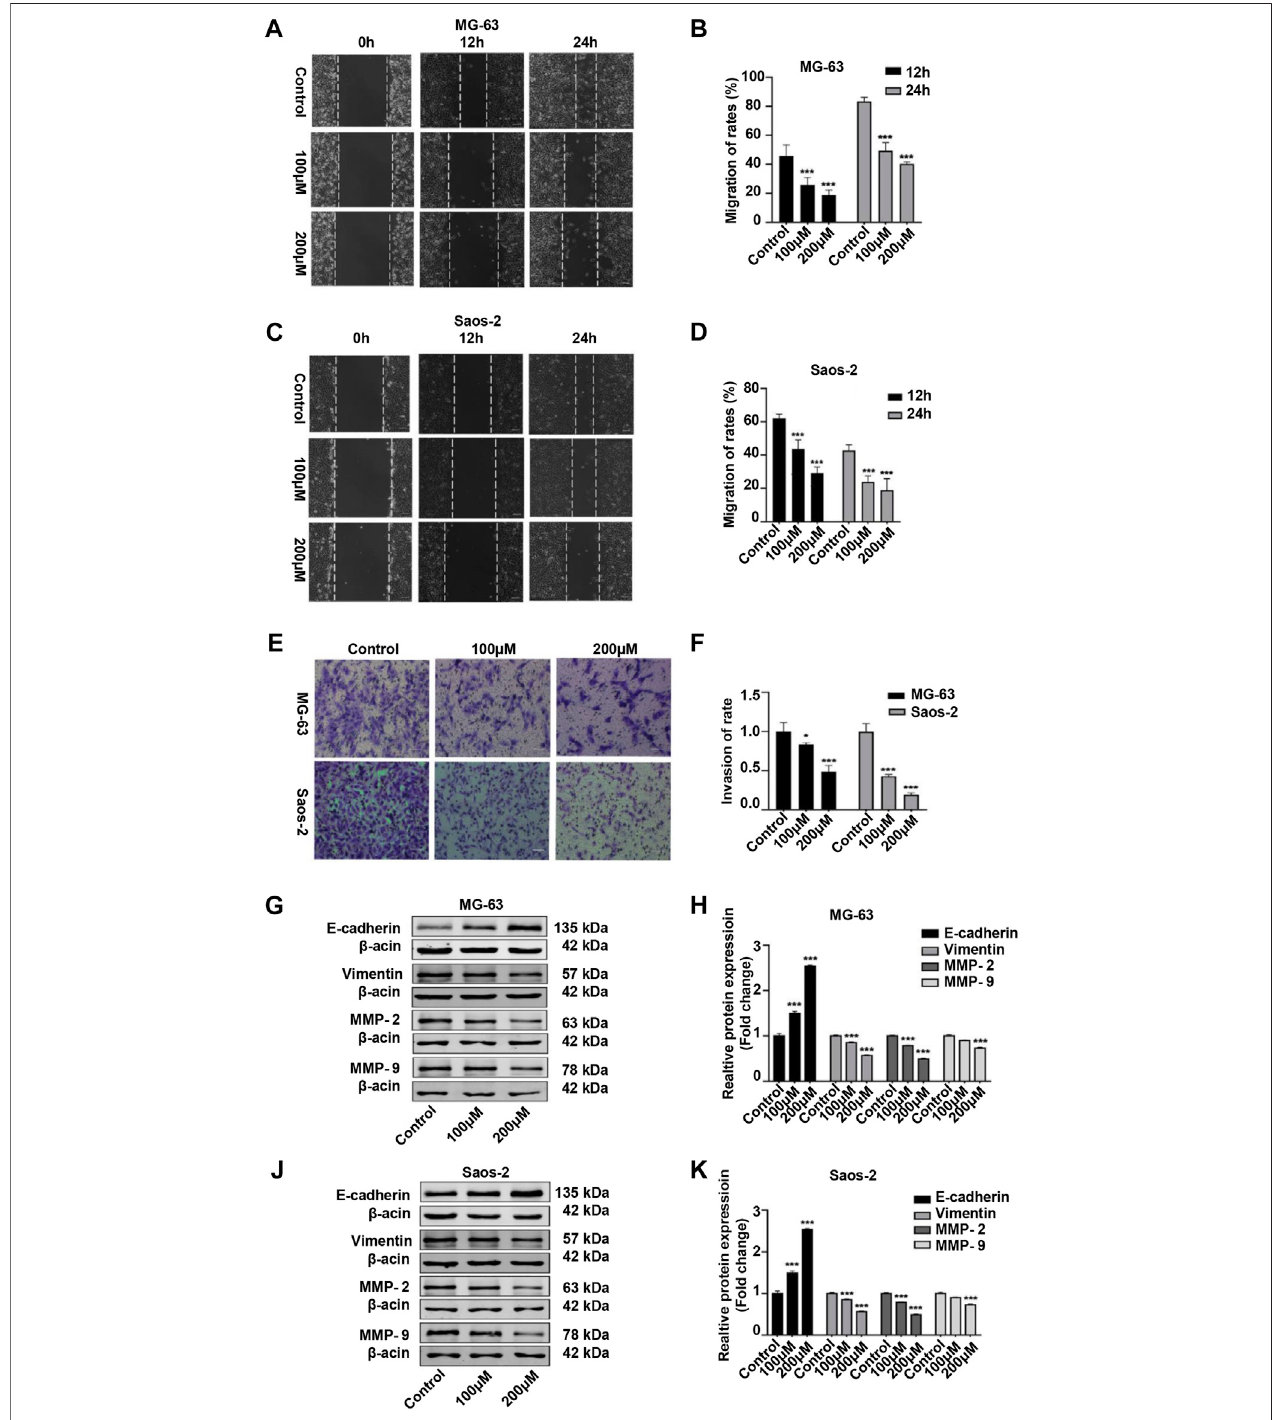
FIGURE 7 | Peiminine suppressed migration and invasion of osteosarcoma (OS) cells. (A,C) Wound healing assay in OS cells treated with peiminine for 0, 12, or 24 h. Scale bar (cid:2) 200 μ m. (B,D) Quantitative analysis of the OS cell migration rate ( n (cid:2) 3). (E) The invasive ability of OS cells was evaluated by Transwell assay following peiminine treatment for 48 h. Scale bar (cid:2) 100 μ m. (F) Quantitative analysis of OS cell invasion rates ( n (cid:2) 3). (G,J) The expression of epithelial to mesenchymal transition (EMT)- and matrix metalloprotease (MMP)-associated markers was measured by western blot in OS cells following peiminine treatment for 48 h (H,K) Quantitative analysis of EMT-related proteins and MMPs ( n (cid:2) 3). * p < 0.05, *** p < 0.001.